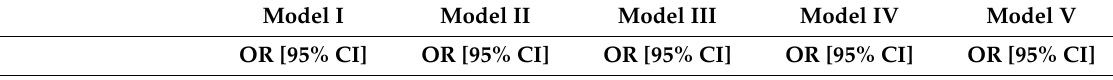
Table 3. Determinants of current tanning bed use based on logistic regression